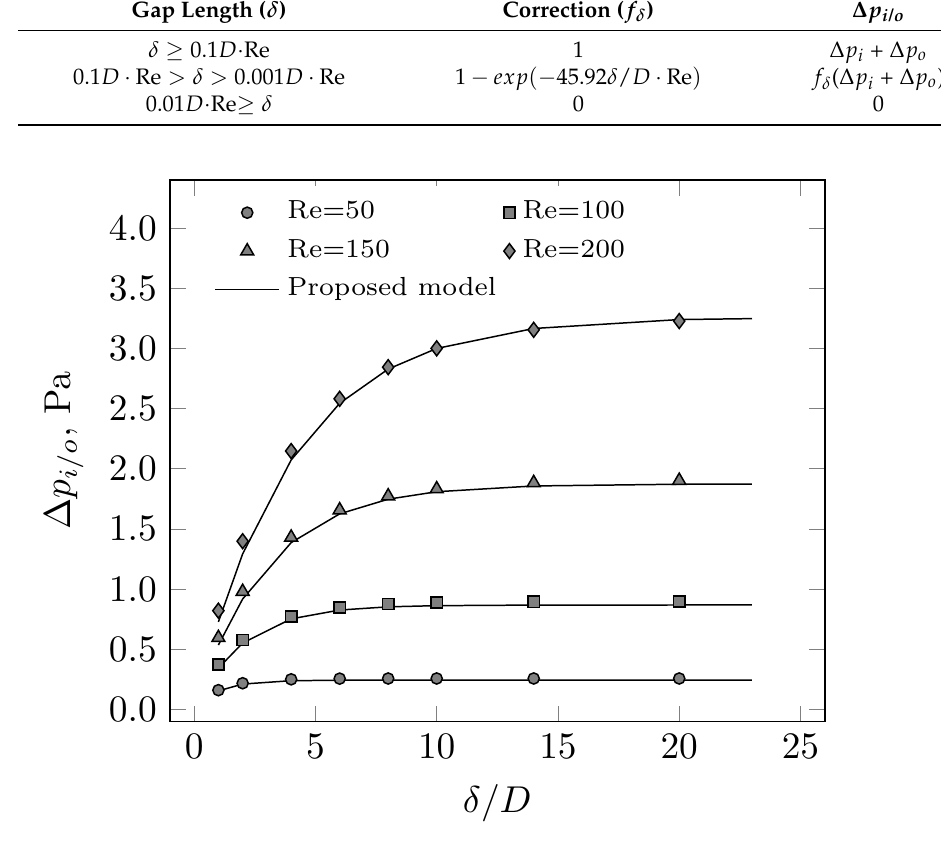
Figure 7. ∆ p i / o from the CFD data compared to that of the proposed